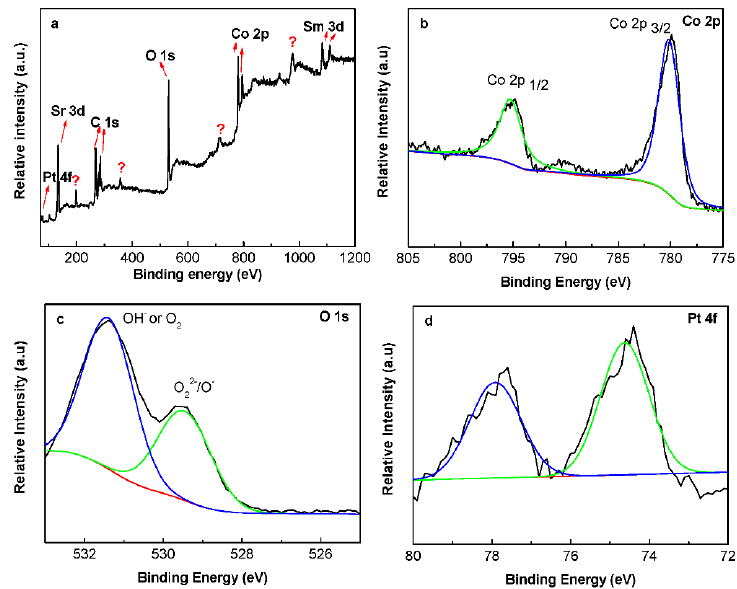
Figure 4. ( a ) Survey scan of (SmSr) 0.95 Co 0.9 Pt 0.1 O 3 , XPS spectra of ( b ) the deconvolution result of Co